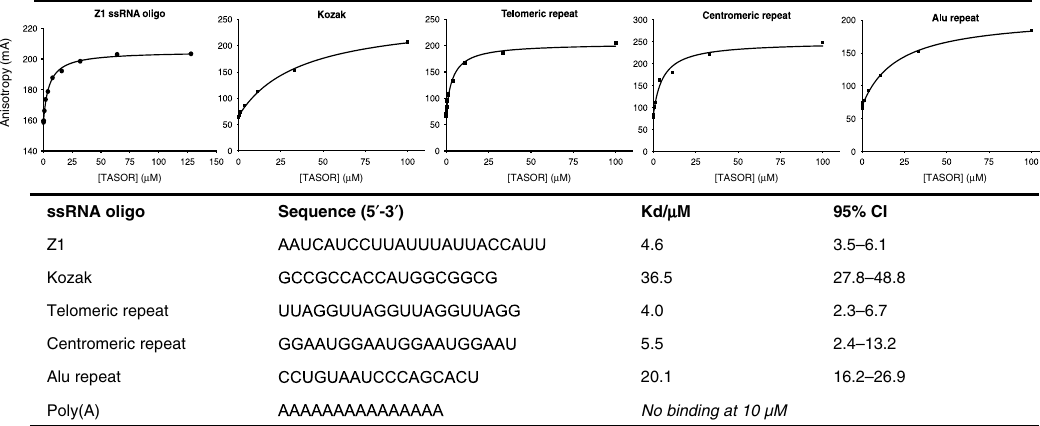
or auto-modi fi cation under the conditions tested (Fig. 5d). We conclude that TASOR ’ s active site is non-catalytic in isolation, like the one in human ZAP/PARP13 (ref. 47 ). ZAP — another non-catalytic human PARP — functions by binding and degrading target viral RNAs 49 . Because of this and the association between TASOR and transcription (Fig. 1), we